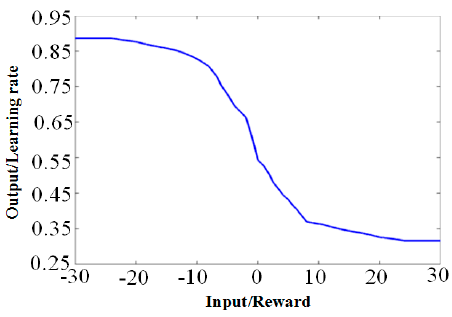
Figure 13. Results of the fuzzy method. Information 2019 , 11 , 341